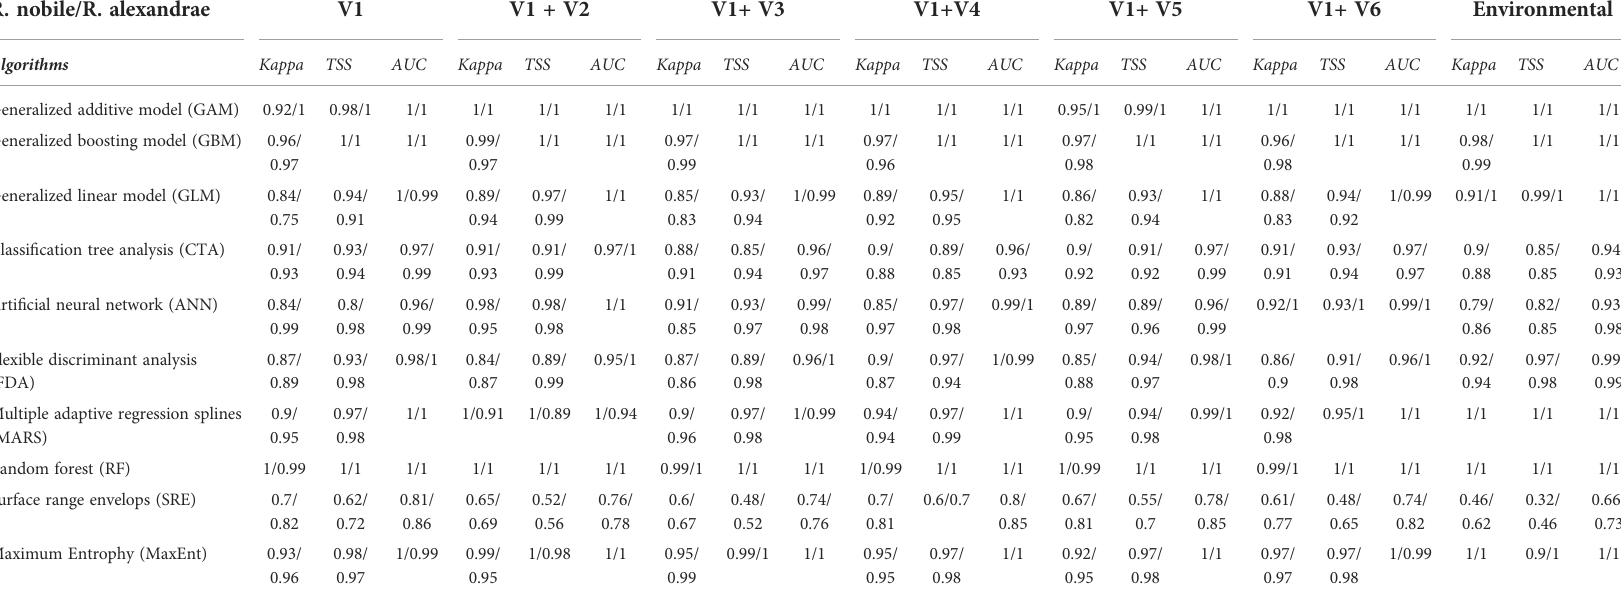
TABLE 2 Model evaluation indices for the ensemble species distribution modeling (eSDM) of Rheum nobile and Rheum alexandrae using Biomod2 in R-programming language. R. nobile/R. alexandrae